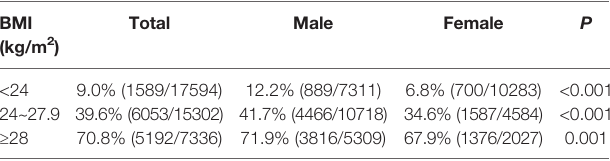
TABLE 3 | Prevalence of FLD among subjects with different BMIs in 2016 [%(n+/n)]. BMI (kg/m 2 )